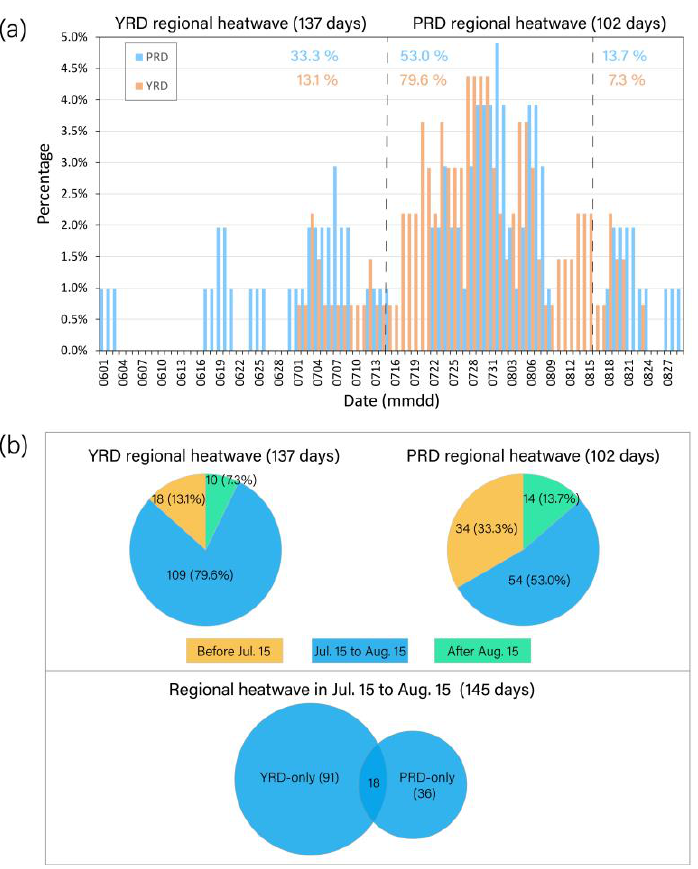
Figure 4. Occurrence frequency of regional heatwaves over the PRD and YRD regions, respectively, during the 10 warm seasons. ( a ) Fraction of heatwaves on each day to the total heatwave days during the warm season. ( b ) Numbers (fractions; unit: %) of the regional heatwave days in the entire warm season and a variety of subperiods, respectively.